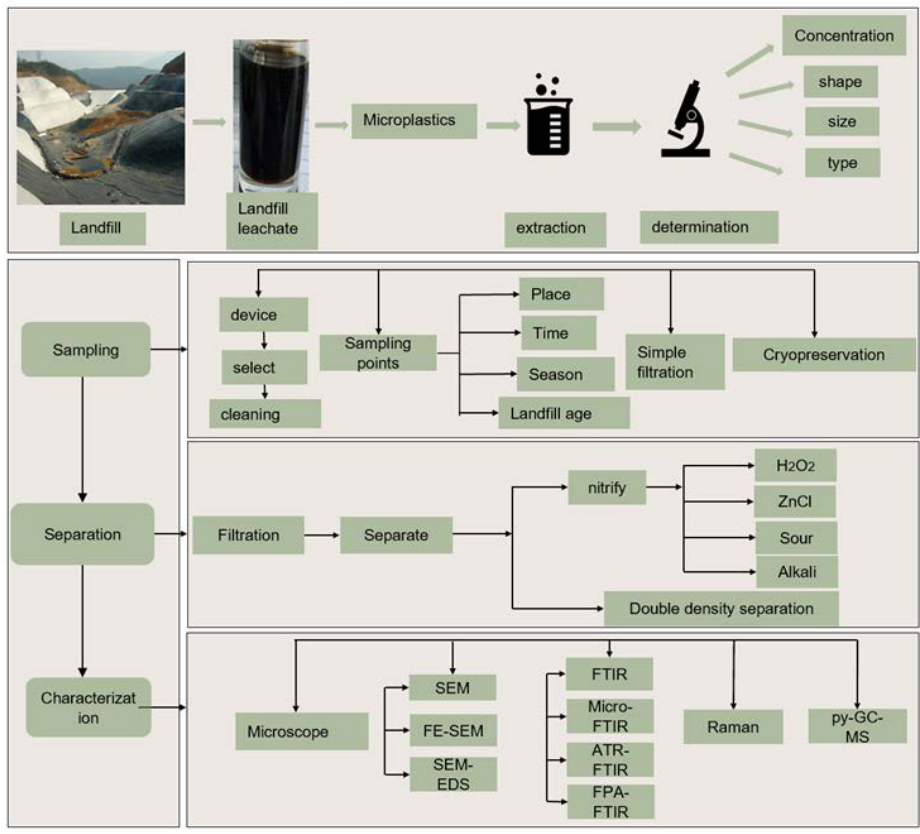
Figure 2. Leachate sampling, separation, and characterization of microplastics in leachate.